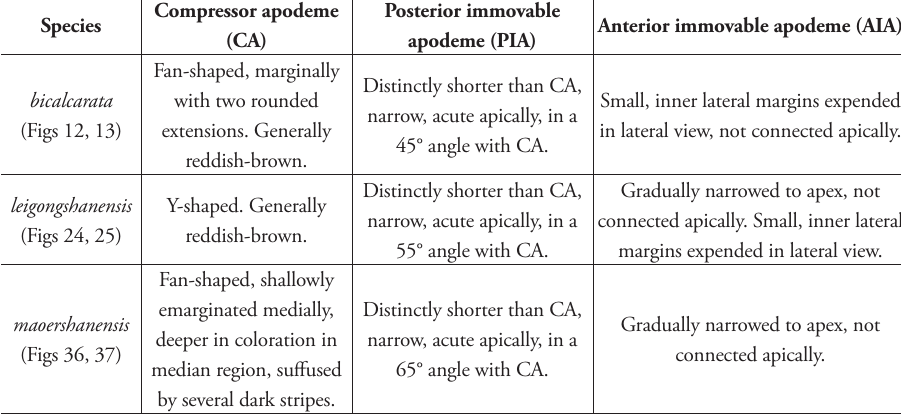
Table 3. Characters of sperm pump in three species of Tipula ( Vestiplex ).